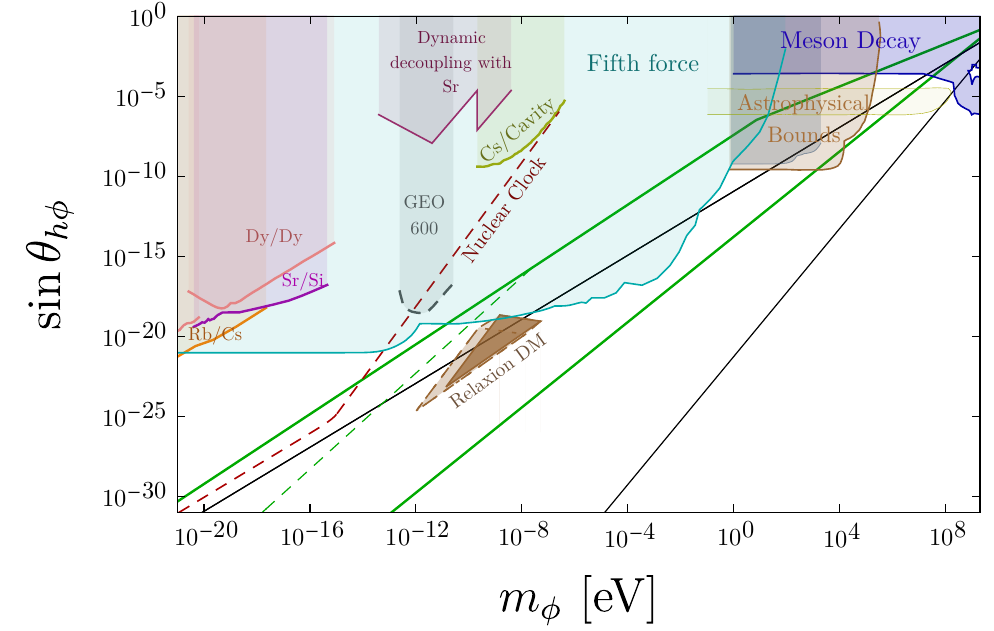
Figure 7 . Updated parameter space for relaxion. The region between two solid green lines de- notes the parameter space for relaxion when it stops at the (cid:12)rst minimum. The region between the black solid lines represents the parameter space for relaxion when it stops at a generic minima (see the discussion in section 5.3). The region above the dashed green line represents super-Planckian decay constant. The brown triangular region represents relaxion DM parameter space as discussed in [8]. The blue, light yellow, light brown, and the light black shaded regions on the top right corner describe excluded parameter space from various collider experiments and astrophysical con- siderations. These are discussed in more detail in section 5.5 and in (cid:12)gure 4. The turquoise, light orange, magenta, pink, and grey dashed shaded region represents constraints on sub- eV relaxion scenario from various (cid:12)fth force and clock-comparison experiments which has been discussed in sec- tion 5.6 and in (cid:12)gure 5. The purple shaded region is excluded by recent clock caparison test with dynamic decoupling [10], while the darker yellow shaded region is excluded by Cesium clock-cavity comparison test